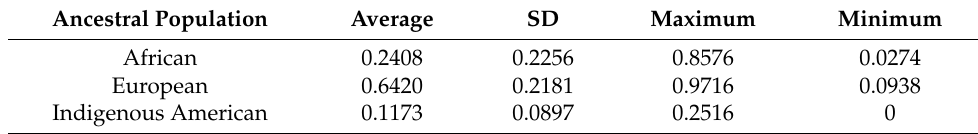
Table 3. Ancestry proportions in the study cohort of 23 Puerto Rican men with prostate cancer.